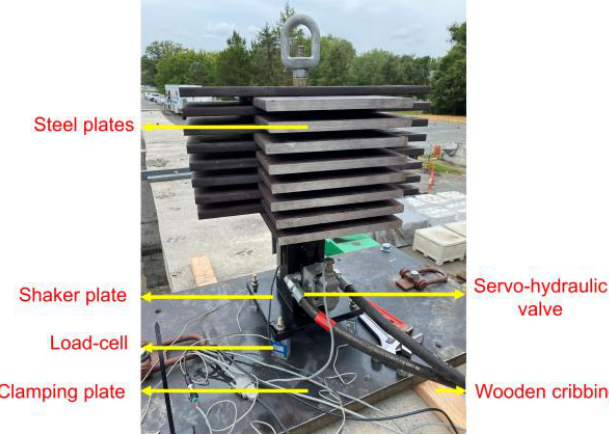
Figure 3. The shaker installed on the girder.